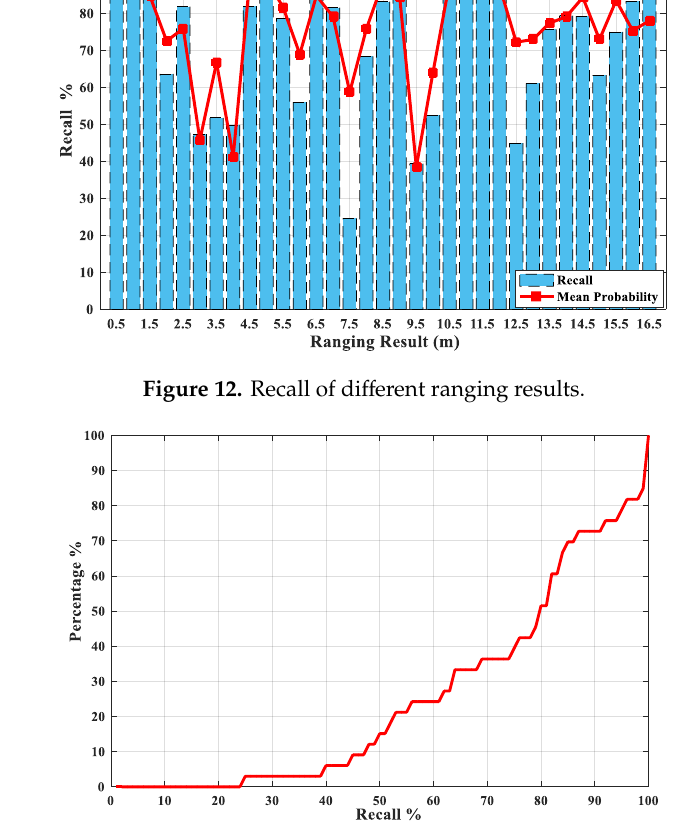
Figure 13. Cumulative distribution function of precisions.